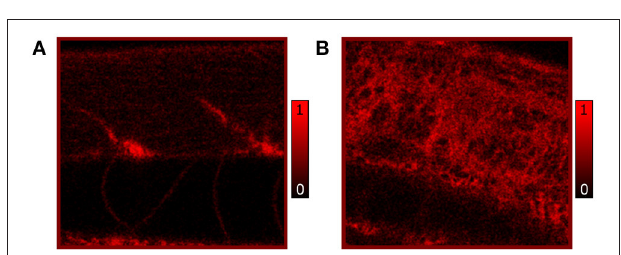
FIGURE 4 | In vivo confocal images of Nile Red stained RAS- (A) and RAS+ (B) 120 hpf larvae imaged with 25x, 0.95 NA water immersion objective. The contrast is based on fluorescence of Nile Red excited with 510 nm laser excitation showing lipid (triglycerides) distribution and content. All images have a field of view (FOV) of 100 × 100 µ m 2